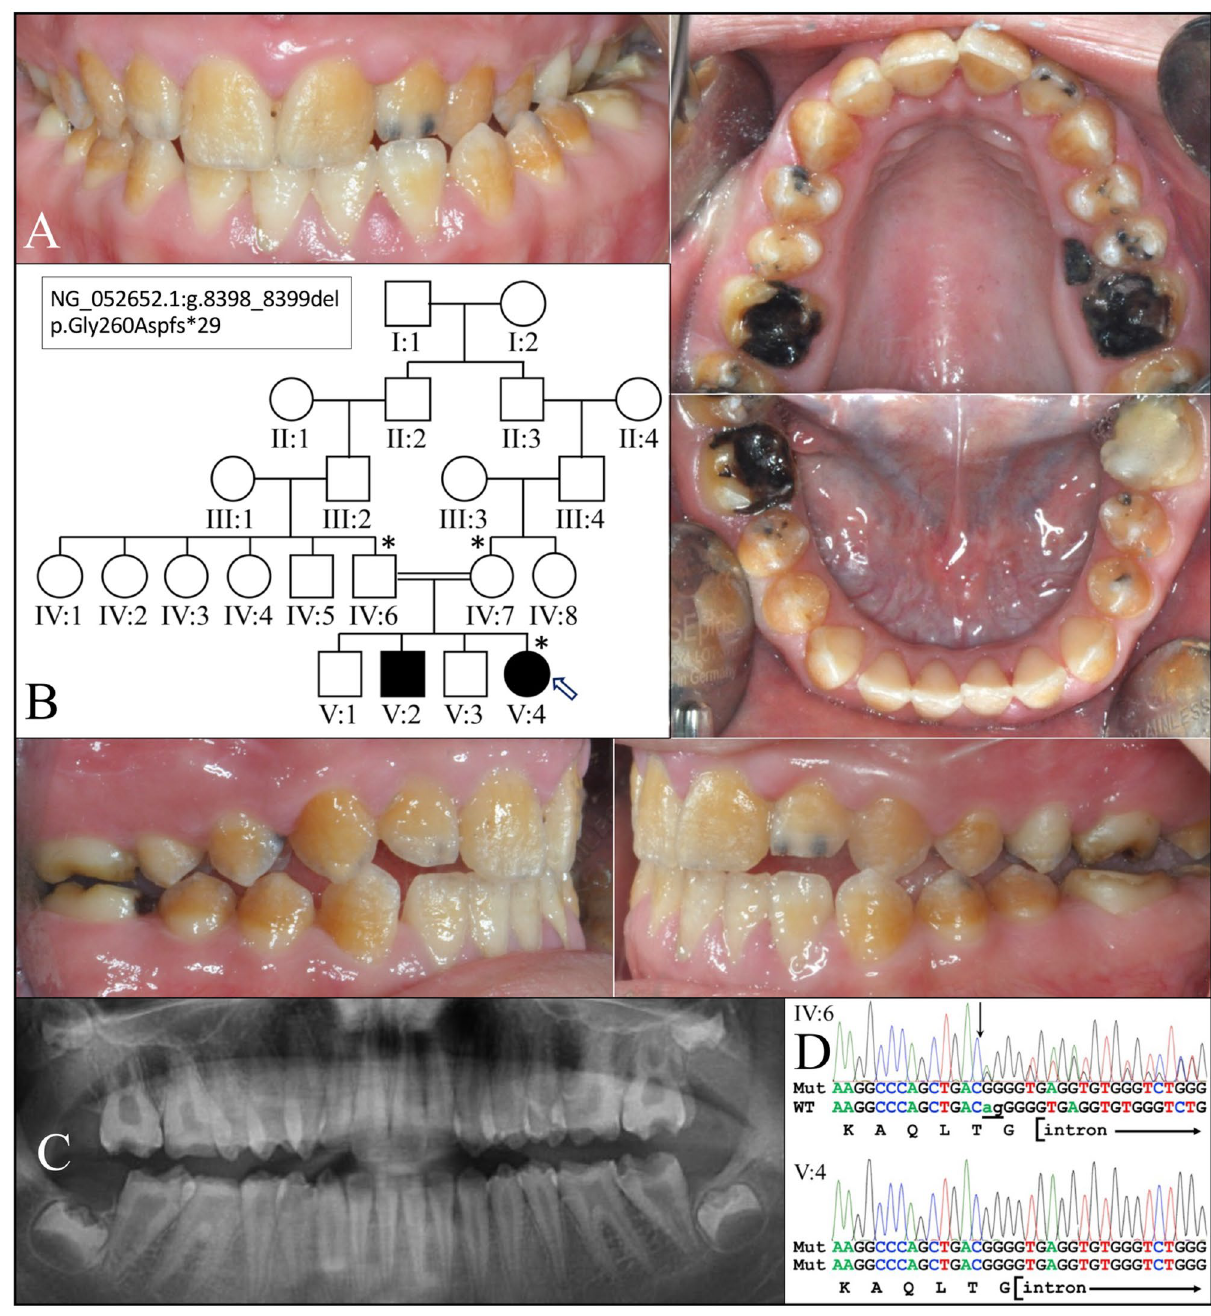
Figure 1. Family 1 with AI Type IJ (OMIM #617297). ( A ) Intraoral photograph of the proband (V:4) at age 14 showed a generalized severe enamel hypoplasia with rough surfaces. ( B ) The family pedigree indicated consanguinity and enamel defects inherited in an autosomal recessive pattern. ( C ) Proband’s panoramic radiograph demonstrated that the enamel in the proband was very thin. The dental pulp chambers appeared to be enlarged, and the first and second molars exhibited taurodontism. ( D ) DNA sequencing chromatograms revealed a novel ACP4 mutation in Exon 7 (NG_052652.1:g.8398_8399del; NM_033068.3:c.774_775del; NP_149059.1: p.Gly260Aspfs*29) which was homozygous in the proband and heterozygous in both